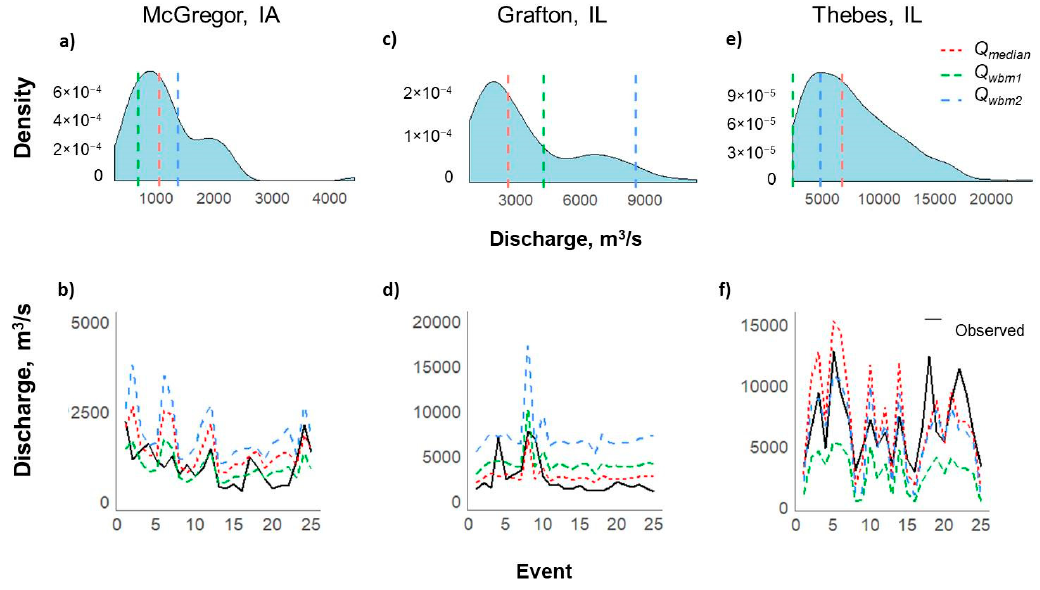
Figure 7. E ff ect of the centers of distribution for Q prior on discharge estimates with study sites 3, 5, and 9 as examples. Top panel: three di ff erent centers of distribution over the density plot of gauge discharge records ( a , c , e ):. Bottom panel: e ff ect of the centers on the discharge estimates for the first 25 events from available Landsat imagery ( b , d , f